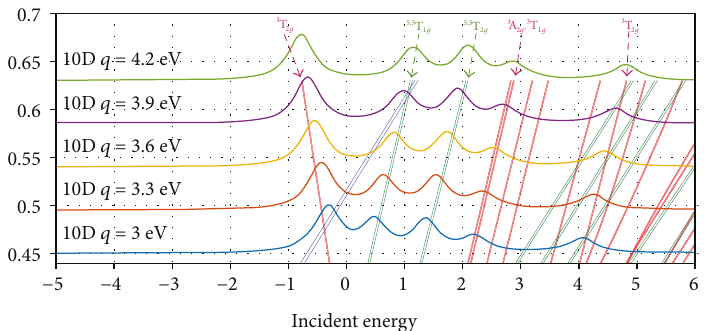
Figure 34: 1s XAS projection of a calculated 1s2p RIXS map for Mn 3+ ( 3d 4 ) in low spin.